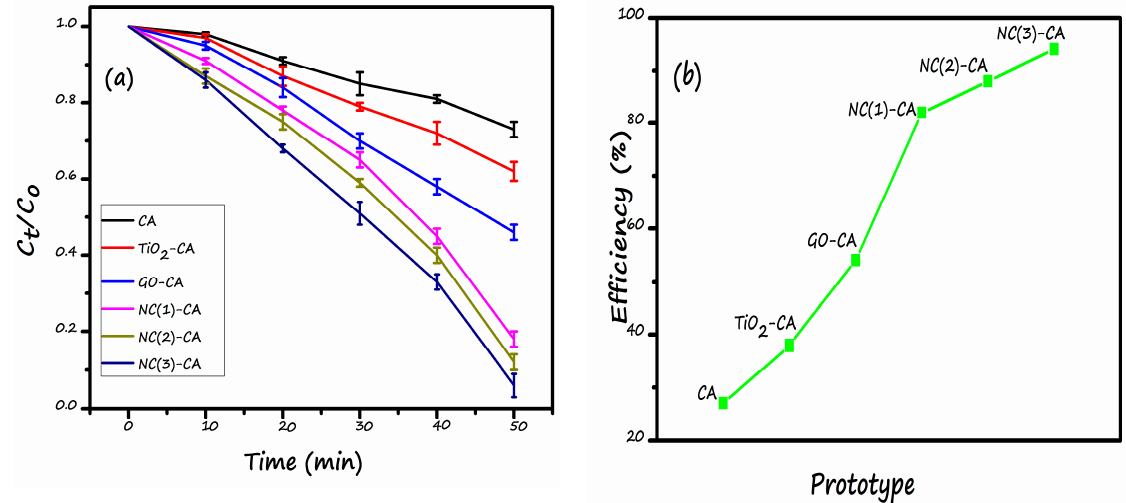
Figure 11. Photocatalytic assessment ( a ) Photodegradation of MO under visible light ( b ) Plot comparing the efficiency of various membrane.